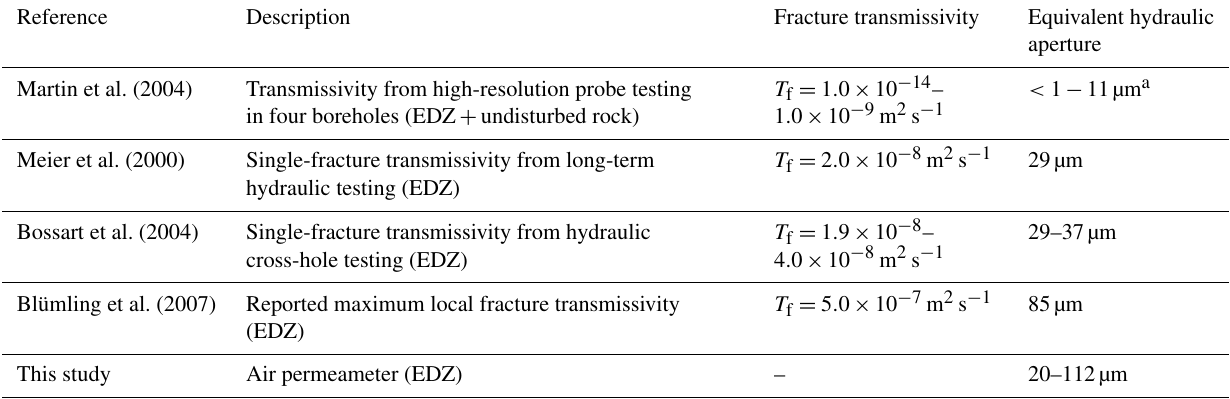
Table 3. Comparison of measured hydraulic fracture aperture (this study) and equivalent hydraulic aperture values derived from reported single-fracture transmissivities from the Opalinus Clay in the Mont Terri URL.